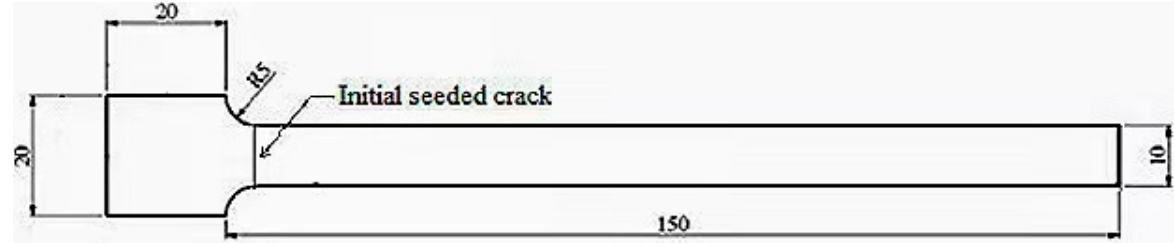
Figure 4. The samples geometry [33].